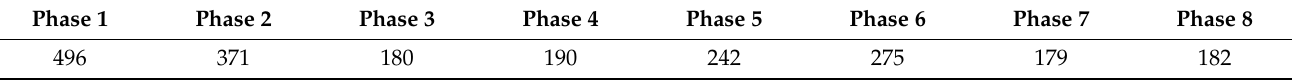
Figure 3. The percentage of total precipitation during the MJO days relative to the summer means in MJO Phases 1–8 ( a – h ) over TP during 1980–2020. Table 1. The case numbers of MJO phases in